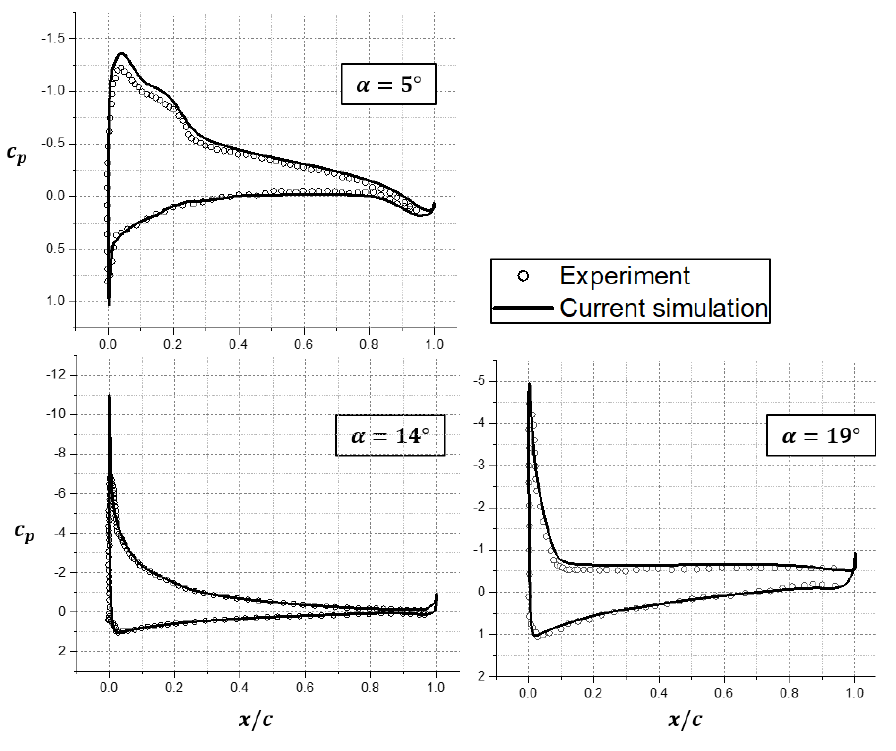
Figure 4. Comparison between experimental data [36] and the current simulation of the OA209. Ma = 0.3, Re = 1.15 M.